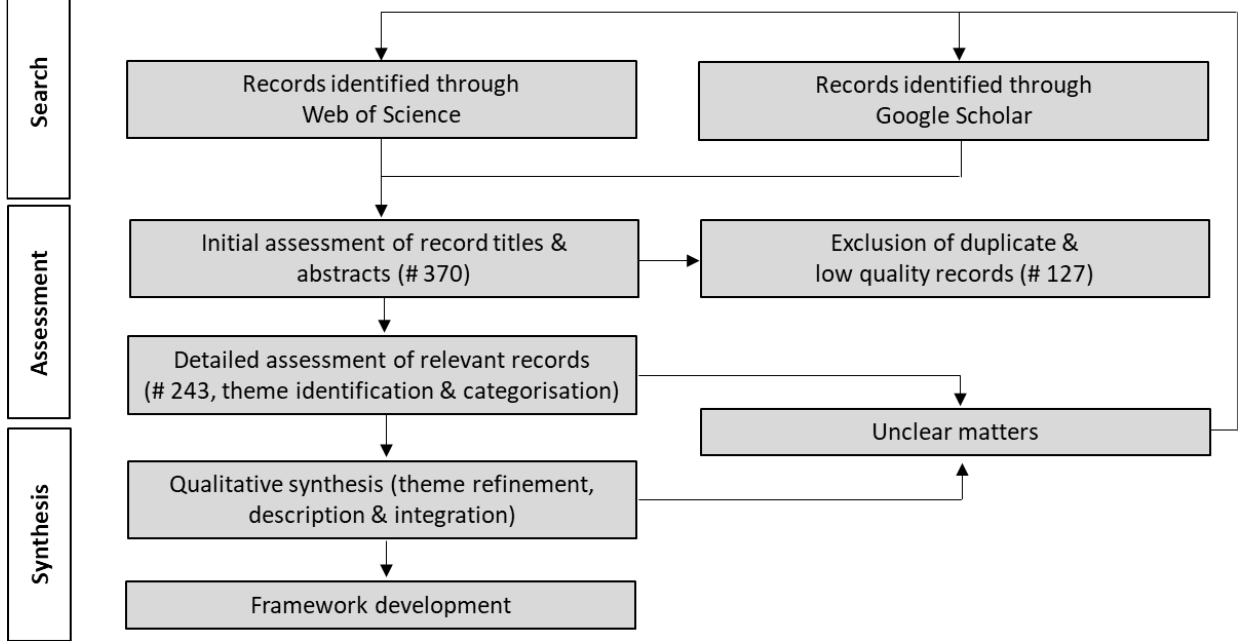
Figure 1. Literature search, assessment, and synthesis procedure. Notes: # refers to the final number of publications considered in the assessment, i.e., after search iteratio ns.